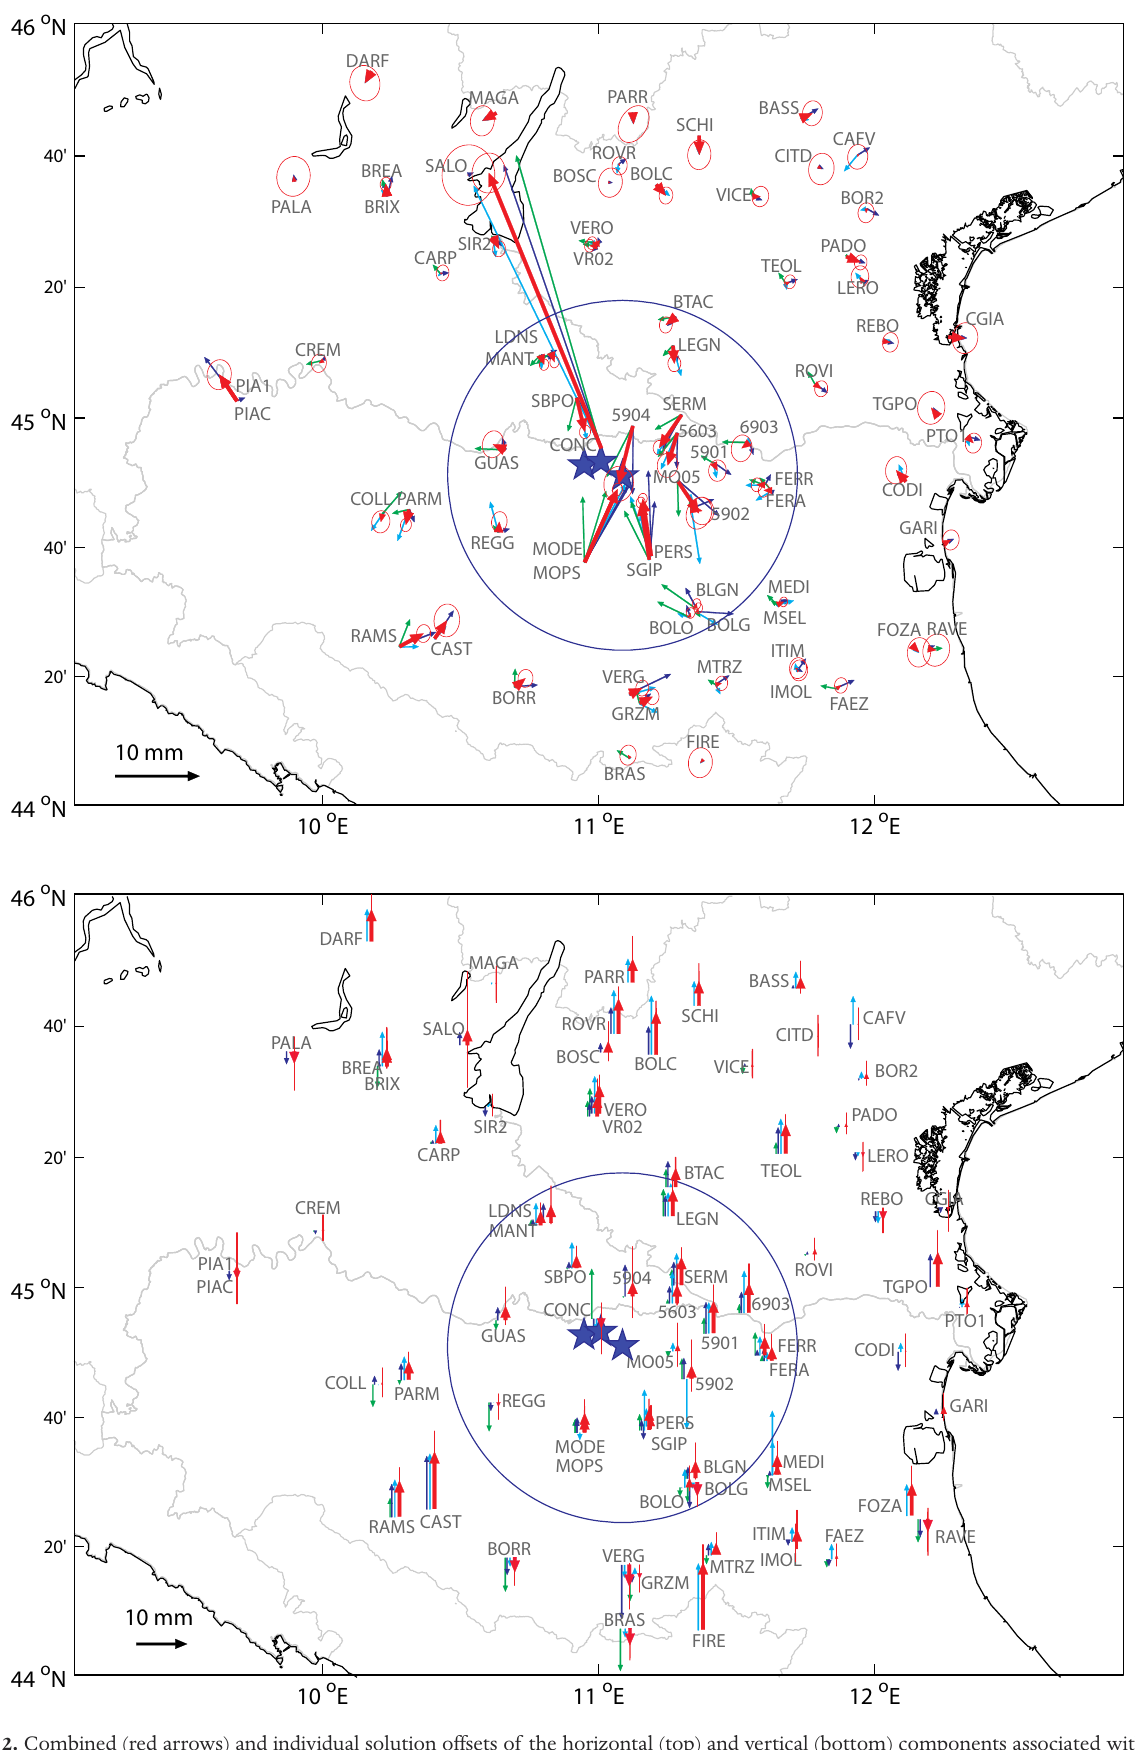
Figure 2. Combined (red arrows) and individual solution offsets of the horizontal (top) and vertical (bottom) components associated with the May 29, 2012, seismic events. The individual solutions are represented in green (BERNESE), cyan (GIPSY) and blue (GAMIT). Stars, epicenters of the M >5 events; circle, delimitation of the 50-km range from the main event (M 5.8); error ellipses, one-sigma confidence